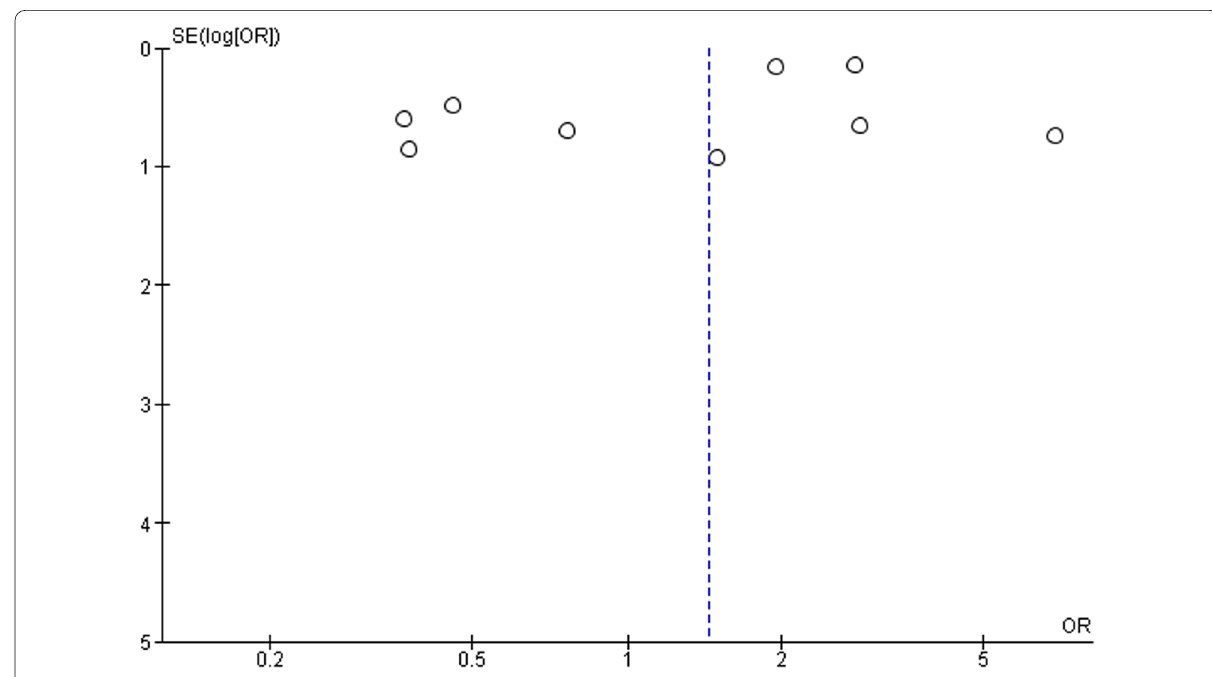
Fig. 5 Funnel plot for the assessment of publication bias